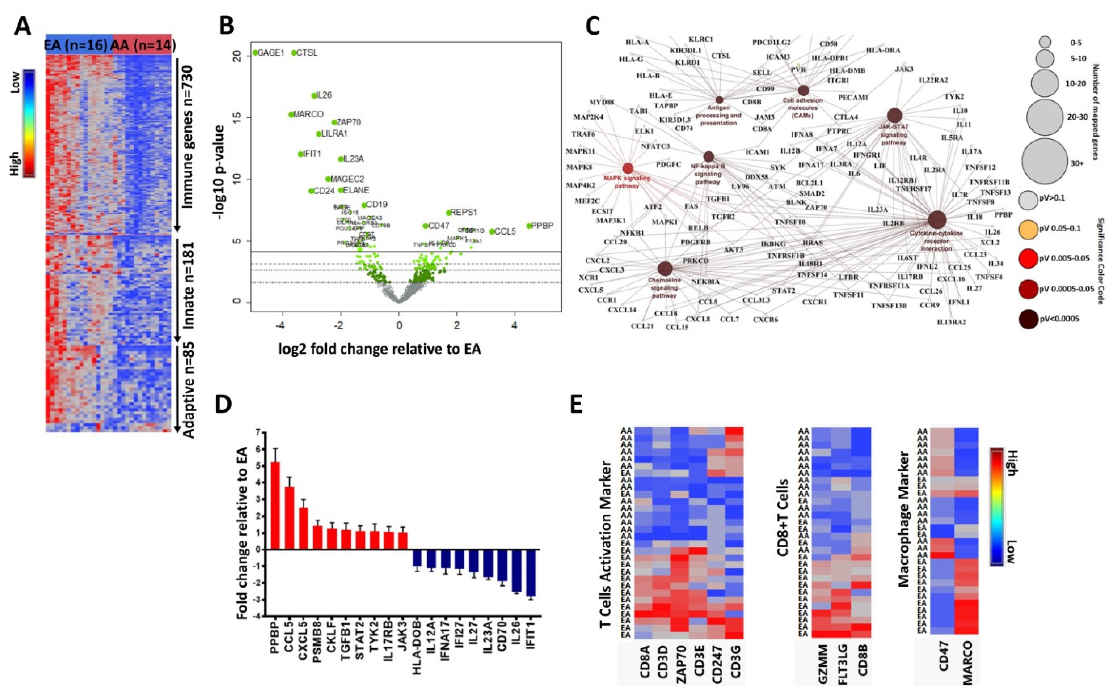
Figure 1. Immune function genes from AA and EA breast cancer exosomes show a racial disparity. ( A ) Nanostring PanCancer Immune gene analysis, which includes 730 immune function genes, showed that, relative to EA breast cancer exosomes, AA breast cancer exosomes had lower expression of overall immune genes as well as innate immune response genes and adaptive immune response genes. ( B ) A volcano plot showed the differential expression of immune genes in AA and EA breast cancer exosomes, where a few genes such as CD47, CCL5, PPBP, and TGFB1 were increased in AA exosomes, whereas CD24, IL26, CTSL, and GAGE1 were increased in EA exosomes. ( C ) Cy- toscape analysis showed that genes interacting through the chemokine signaling pathway, the cy-